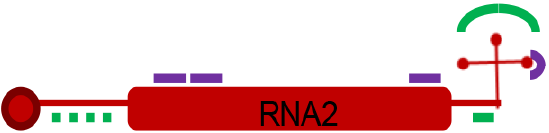
Figure 2. Binding pattern for DExD/H-box ATP-dependent RNA helicase 1 (Dhh1) and the Lsm1–7/Pat1 complex to brome mosaic virus (BMV) RNA2. Dhh1 binds to three sites in the open reading frame (ORF) and to the tRNA-like structure (TLS) in the 3′ untranslated region (UTR) (purple color). The Lsm1–7/Pat1 complex binds to both the TLS and the non-tRNA-like structure in the 3′ UTR and also with lower affinity to the 5′ UTR (green color).